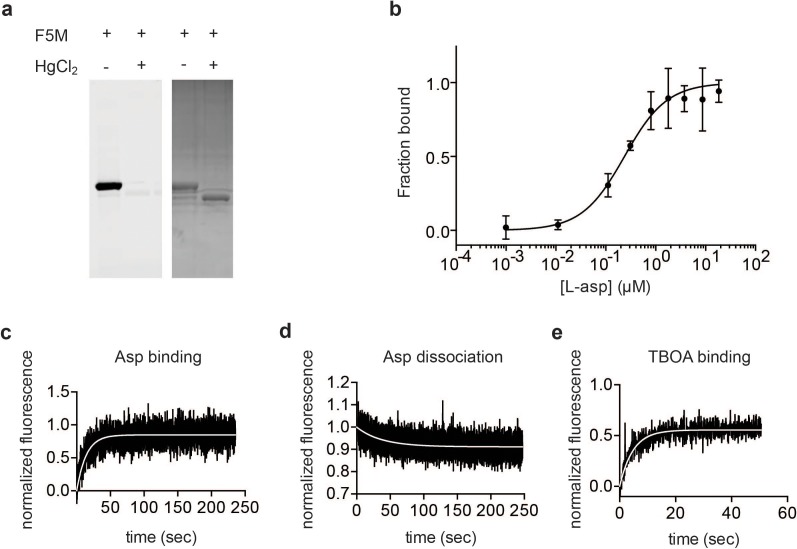
Characterization of P11WIFS GltPh.(a) SDS PAGE analysis of fluorescein-5-maleimide (F5M) labeled uncrosslinked and Hg2+-crosslinked P11W/K55C/A364C GltPh (P11WIFS), imaged under blue illumination (left) and stained with Coomassie Blue (right). (b) Titration of P11WIFS GltPh with L-asp followed by tryptophan fluorescence in the presence of 10 mM Na+. Data were normalized and fitted to a single binding site quadratic equation yielding KD of 228 ± 85 nM. Representative kinetic experiments of 0.5 mM L-asp binding to P11WIFS in the presence of 4 mM Na+ (c), L-asp dissociation from P11WIFS in the presence of 0.2 mM Na+ (d), and 8 mM DL-TBOA binding to P11WIFS in the presence of 4 mM Na+ (e). Data were normalized as described in Materials and methods. The white lines are fits to single exponential functions yielding kobs values of 0.0712 s−1, 0.027 s−1, and 0.2106 s−1, respectively.